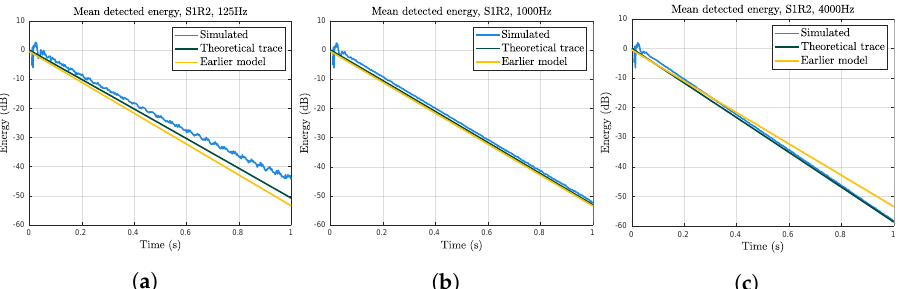
Figure 3. Comparison between the theoretical estimate of the mean detected energy (Equation (7), green), the estimate found in [14] (yellow), and an approximation based on simulations (light blue). Note that only the scattering coefficient and air absorption vary between the octave